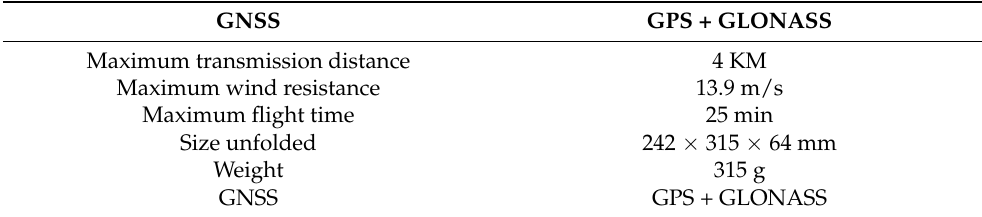
Table 1. Specifications of Parrot aniafi thermal UAV.